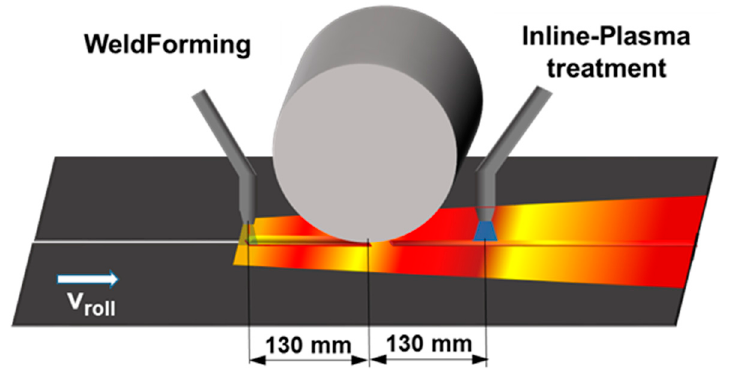
Figure 22. WeldForming with Inline-Plasma treatment.